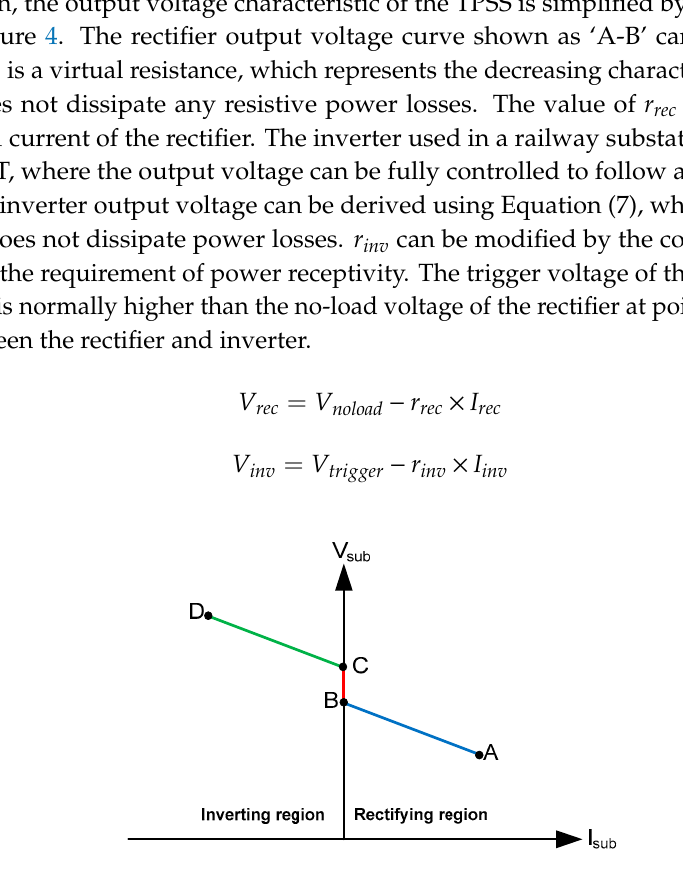
Figure 4. Traction power substation voltage regulation.